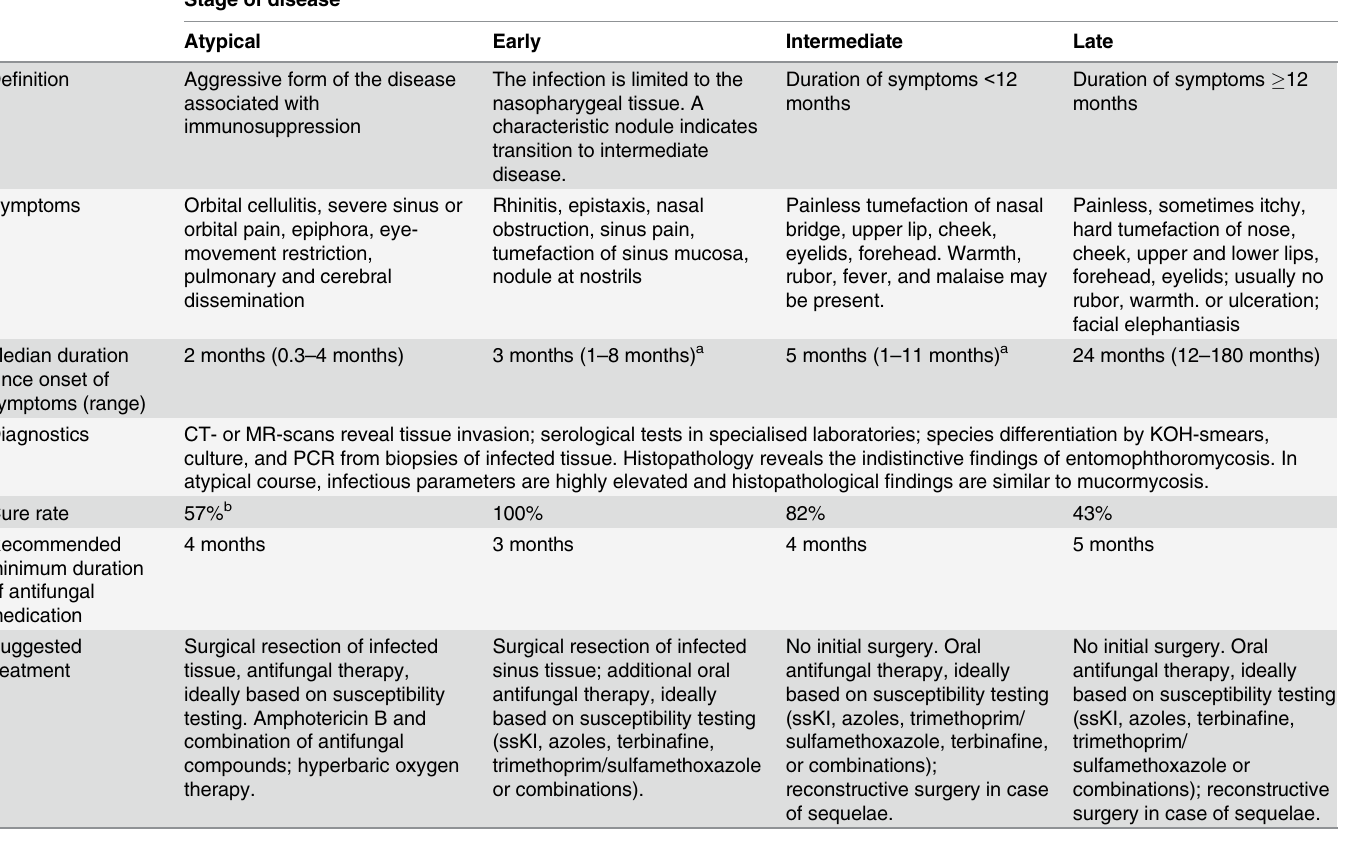
Table 3. Suggested staging system of